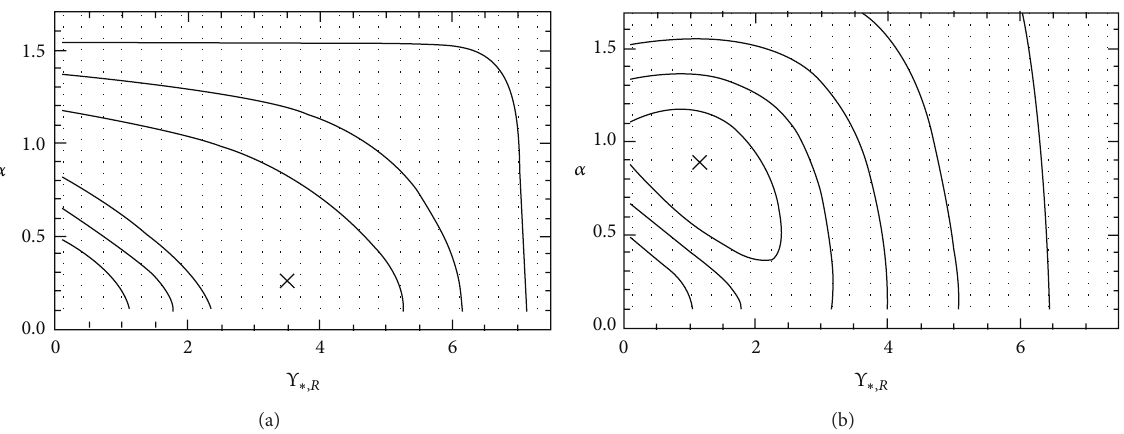
Figure 3: Confidence intervals for the inner slope of the DM halo ( 𝛼 ) and the 𝑅 -band mass-to-light ratio ( Υ ∗,𝑅 ) for NGC 2976. The left panel shows the result of leaving both parameters free while fitting. The right panel shows the same fit but constraining Υ ∗,𝑅 to lie within the limits allowed by a synthetic stellar population fit to the integrated optical spectra and SED of the galaxy. Taken from Adams et al.